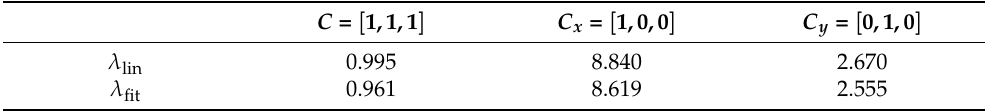
Table 1. Maximum conditional Lyapunov exponent estimated using the asymptotic distance between master and coupled slave systems ( λ sim ) and derived from linear fit ( λ fit ).